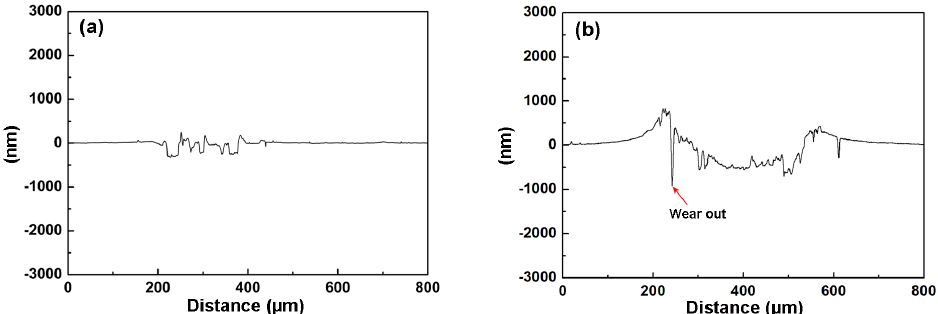
Figure 9. Cross-sectional profiles of the wear track after sliding test: ( a ) in air; ( b ) in NaCl solution.